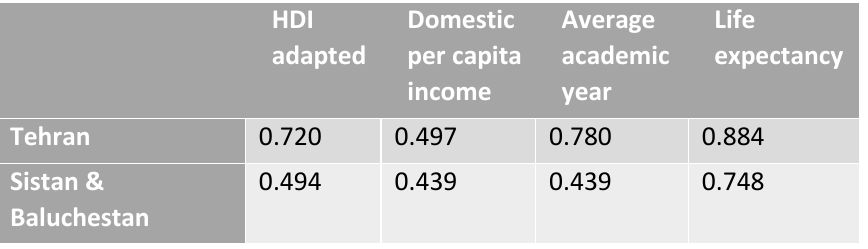
Table 4: HDI values in Tehran and Sistan &